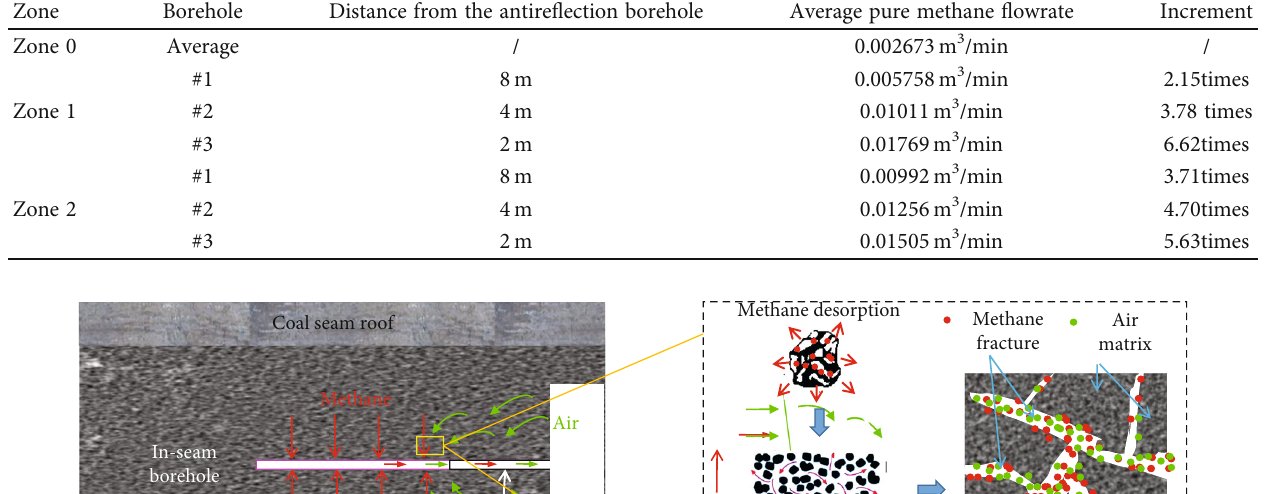
Table 3: Data analysis of pure methane fl owrate in borehole.